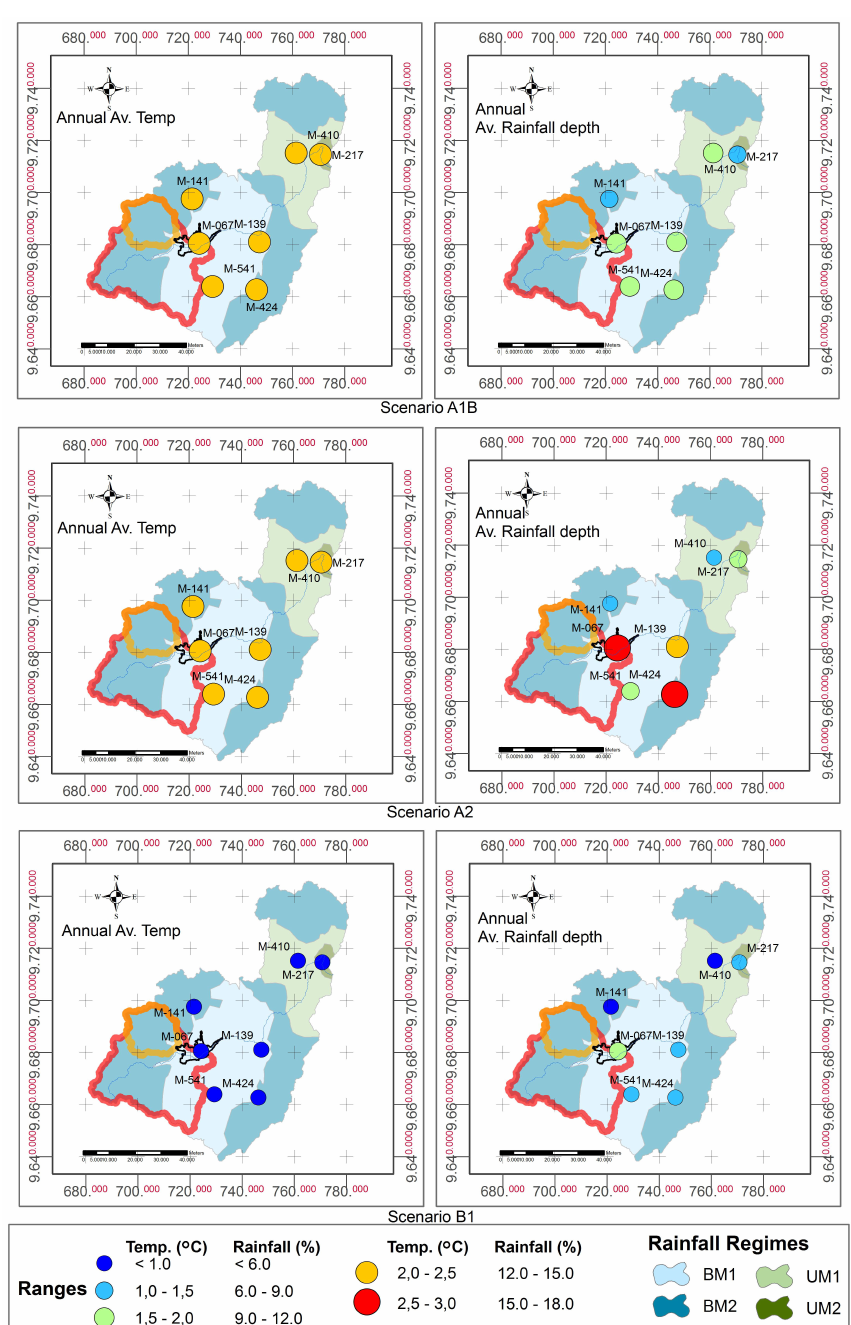
Fig. 8. Map of average change for annual temperature and annual rainfall depth (2045–2065, all scenarios).